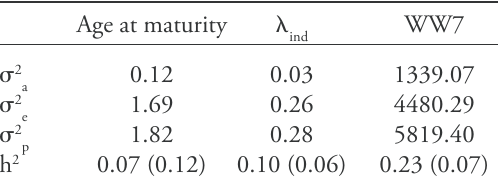
s 2 = direct additive genetic variance, s 2 a variance, s 2 = phenotypic variance, h 2 = heritability p (and its standard error in